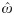
The number of binding sites enhances oscillatory behavior.Peak frequency ω^ (panel A) and the quality factor Q90% (panel B) as a function of ϵ and λ, for oscillations in the number fluctuations of repressor for the same parameter than Fig 4, but with N = 5 instead of N = 3.